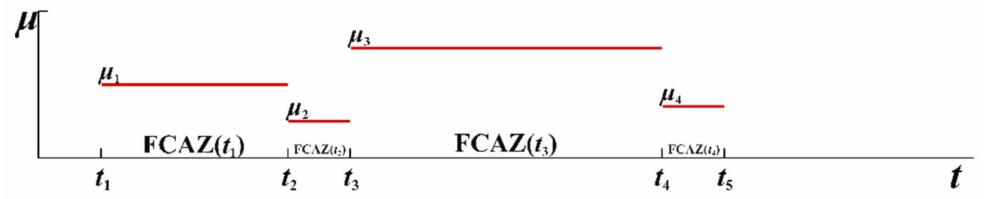
Figure 13. Illustration of the systems analysis method developed based on FCAZ recognition. Deep red color shows the values of the FCAZ recognition quality measure at different time